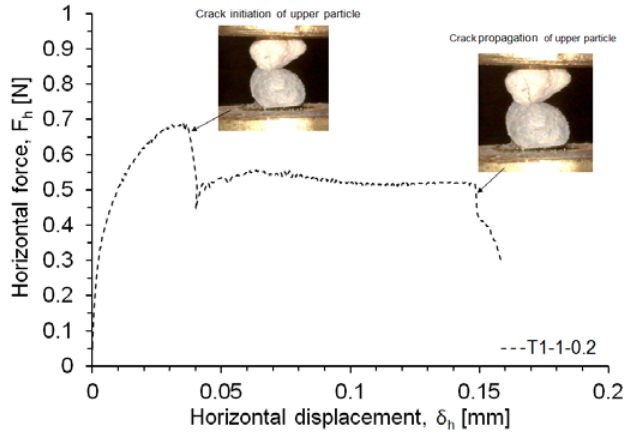
Figure 10. Sliding experiment on CDV granules with observation of crack initiation and propagation during shearing.